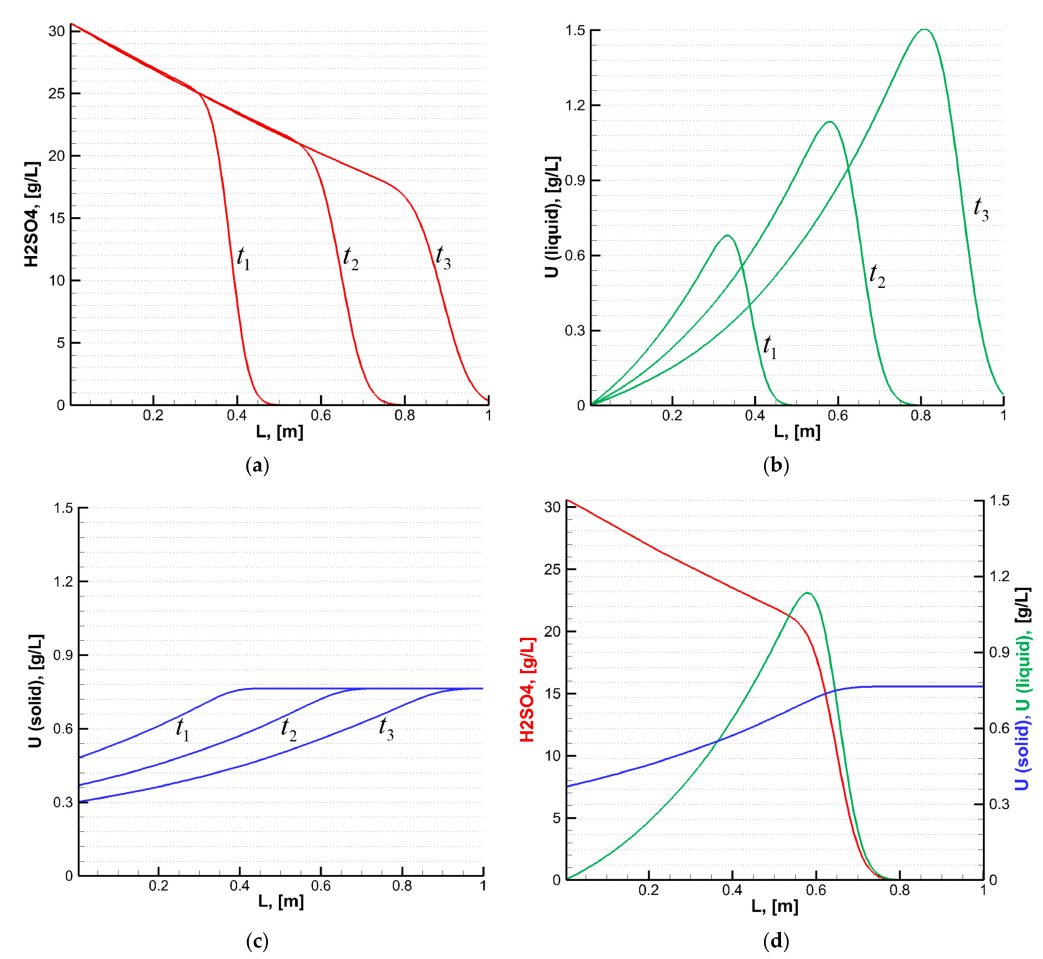
Figure 7. Distributions of ( a ) solid uranium, ( b ) reagent, and ( c ) dissolved uranium along the tube at different time periods t 1 = 12 [h], t 2 = 22 [h] and t 3 = 32 [h]; ( d ) ( right down ) distributions of solid uranium, reagent and dissolved uranium at time t 2 .